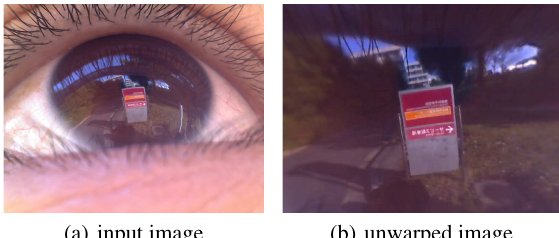
Figure 8 . Results obtained after generating an unwarped corneal surface image. The left and right images are the input image and the generated unwarped corneal surface image, respectively.